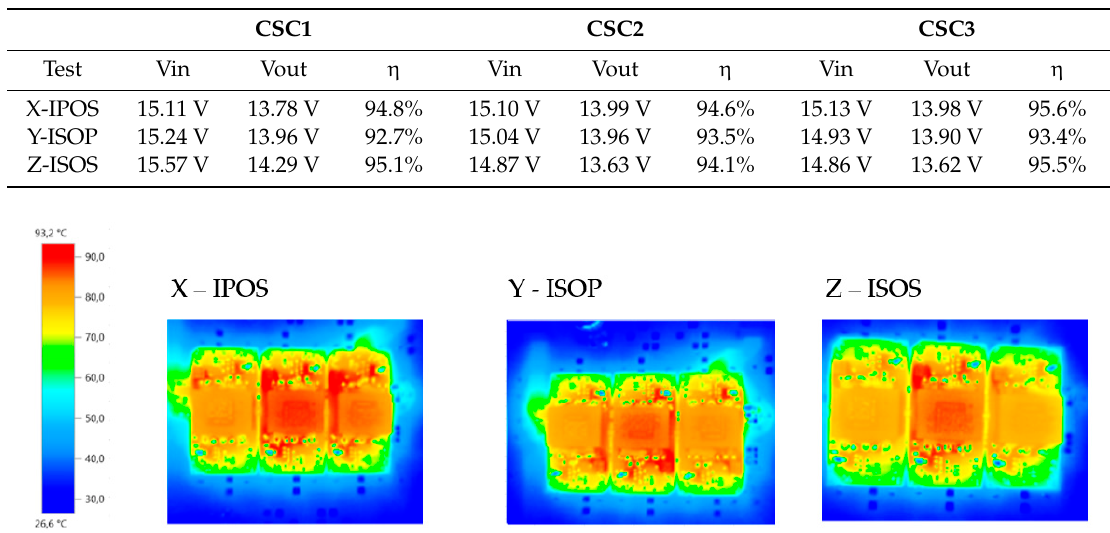
Table 7. PCA of 5 BBCBA CSCs configured in ISOS.